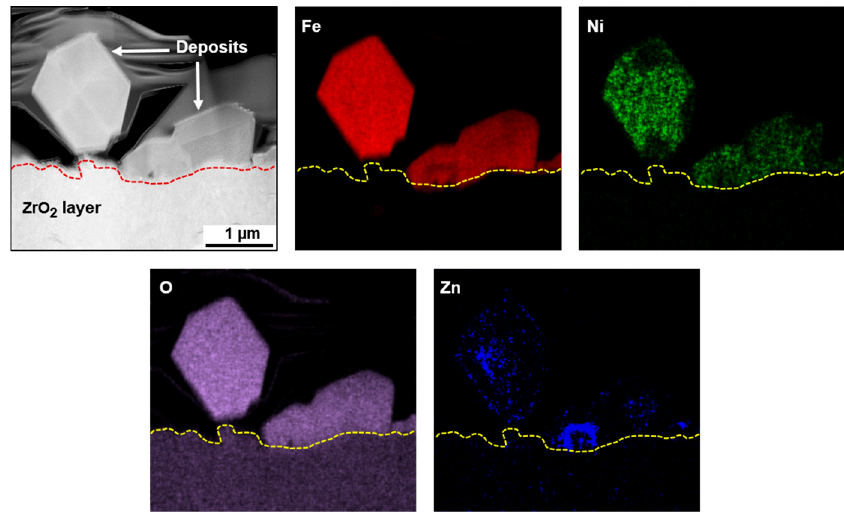
Figure 4. STEM micrograph and elemental EDS maps of fuel deposits formed in the coolant with 20 ppb of zinc (Case #2).